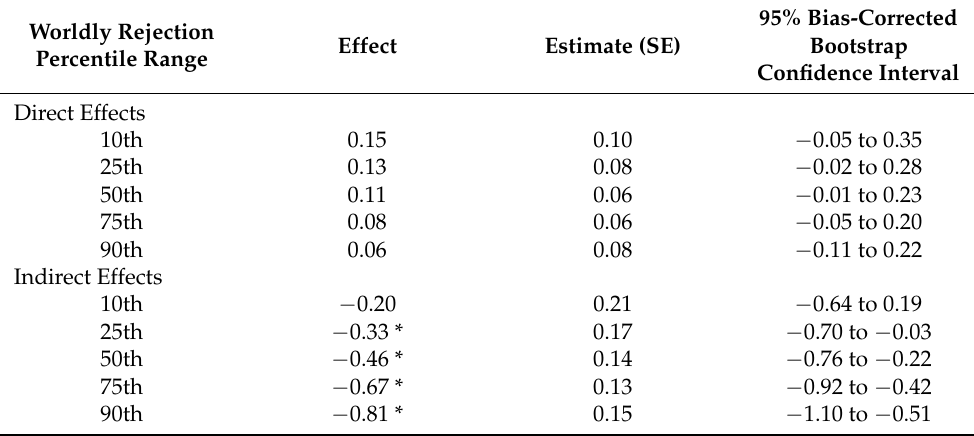
Table 7. Conditional Direct and Indirect Effects in Model with Worldly Rejection. Worldly